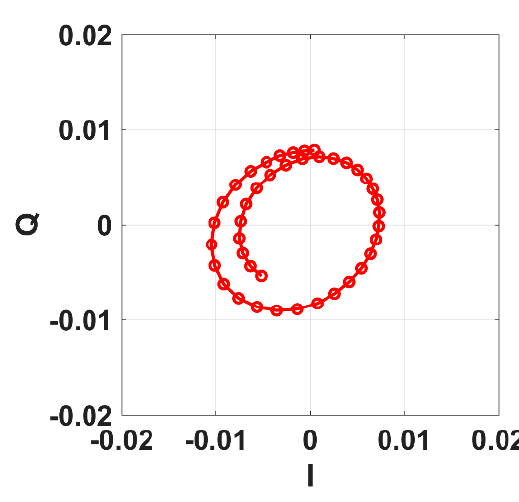
Figure 11. I / Q plot. Figure 11. I/Q plot.